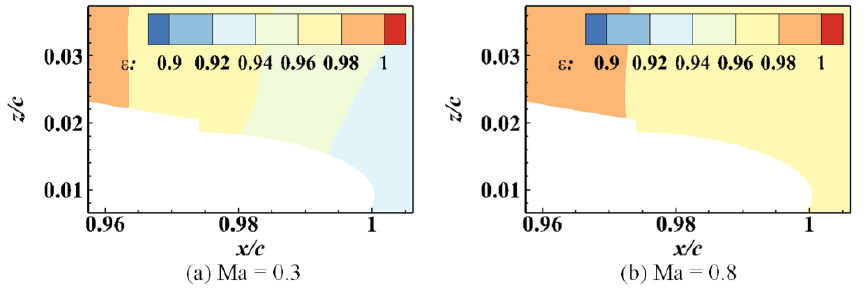
Figure 12. Amplification coefficient contours of the baseline model. A similar variation in C pt along the upper Coanda wall reflects the characteristics of the under-expanded CC jet in both freestreams, which further supports the above con- clusion. The surface pressure coefficient C pt is defined as C pt = ( p s − p 0, plenum ) / p 0, plenum . The variable p s denotes the surface static pressure distribution. Figure 13 shows the C pt distributions on the Coanda surface for Ma = 0.3 and Ma = 0.8. For the same NPR values, only a slight discrepancy in the distribution is found between Ma = 0.3 and Ma = 0.8, which indicates that the CC jet features are very similar for both incoming flows for the same NPR.